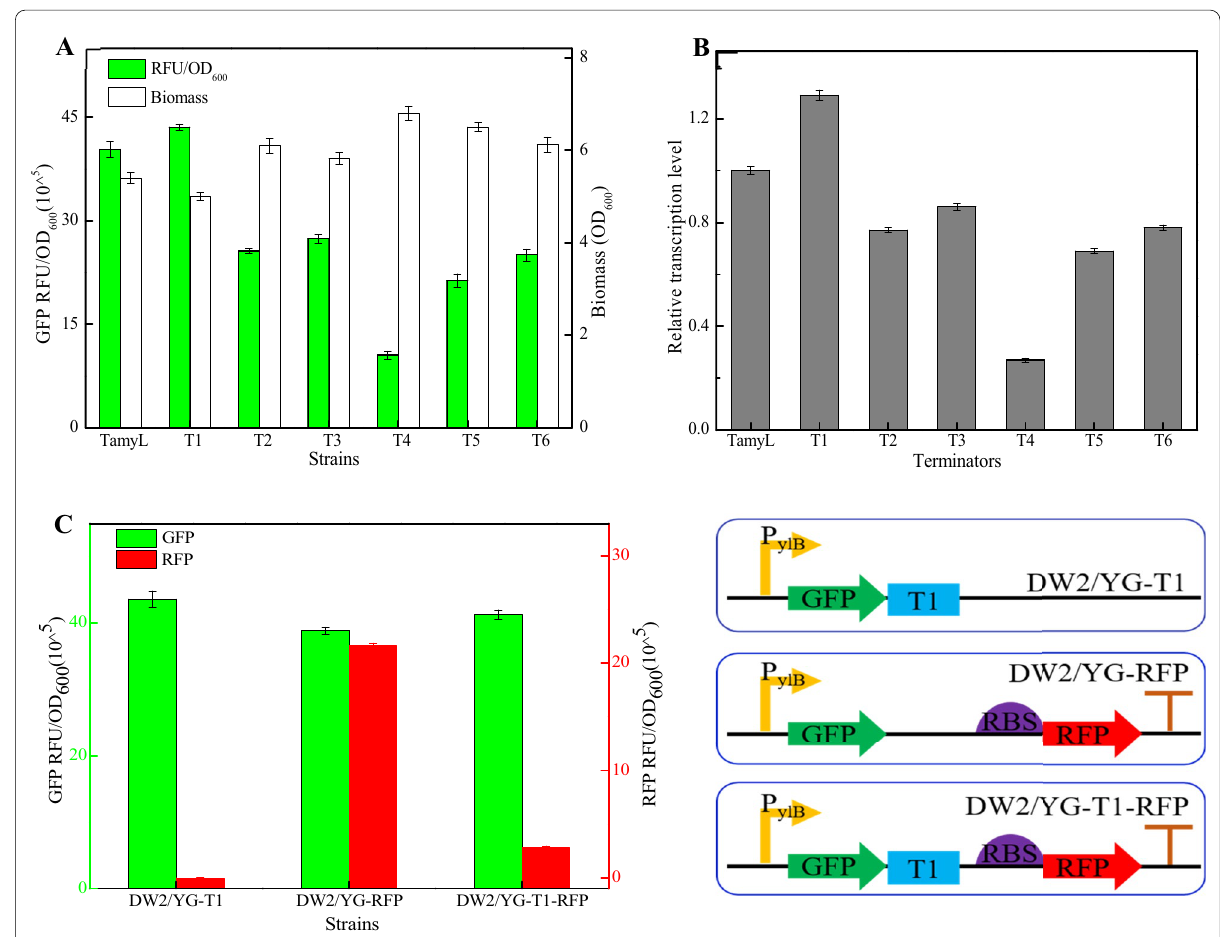
Fig. 1 Identification and characterization of α-amylase terminator. A Green fluorescence intensities and cell biomasses of GFP expression strains with different terminators (T1–T6). B Relative transcriptional levels of gfp . C Dual-gene reporter system for termination efficiency